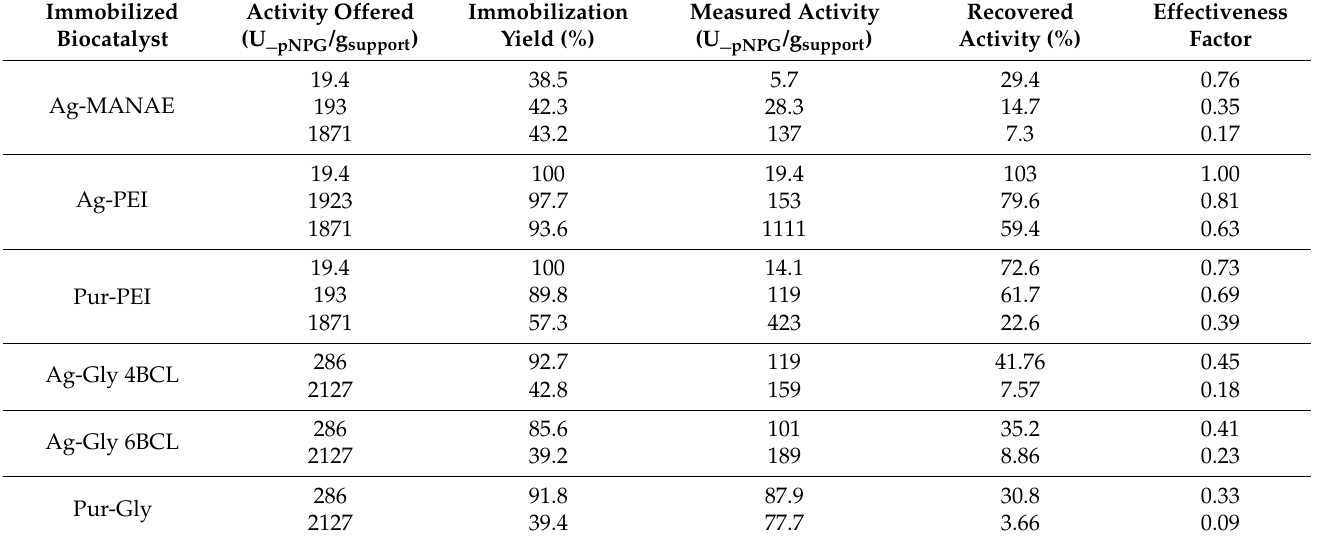
Table 1. Characterization of the immobilization of the β -glucosidase on different activated supports. For more details of the immobilization parameters definitions see Section